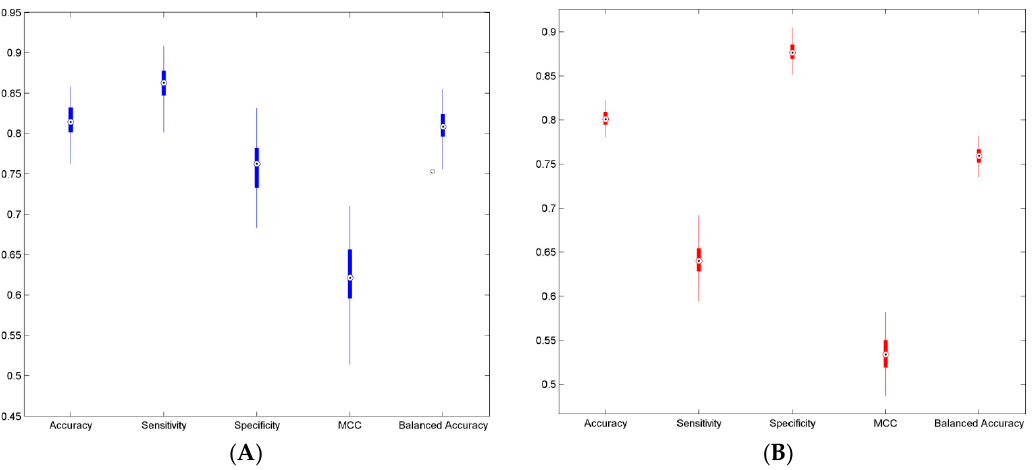
Figure 3. Boxplot of performance parameters of the five-fold cross validations. Prediction accuracy, sensitivity, specificity, Mathews correlation coefficient (MCC) and balanced accuracy of the 200 iterations of five-fold cross validations were plotted for TS-1 ( A ); and TS-2 ( B ). The parameters were indicated at the x-axis and their values were presented in the y-axis.